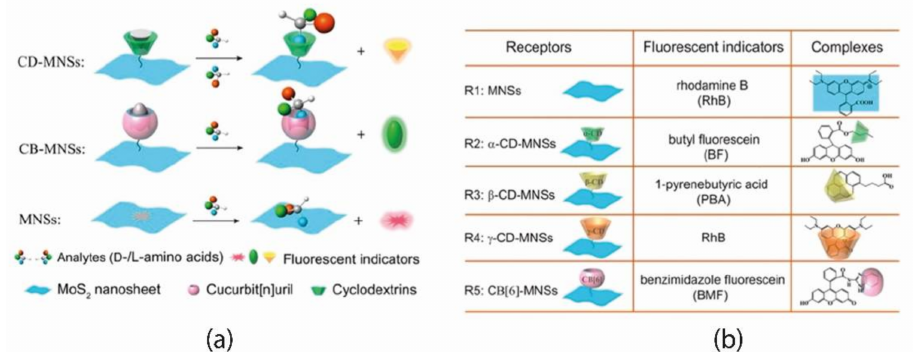
Figure 9. Sensing array developed by Wei and coworkers. ( a ) Illustration of the competitive in- teraction between analytes and fluorescent indicators with host molecules, leading to fluorescence intensity variation; ( b ) main components of the fluorometric sensor array. Adapted from Ref. [41] with permission from the American Chemical Society, copyright